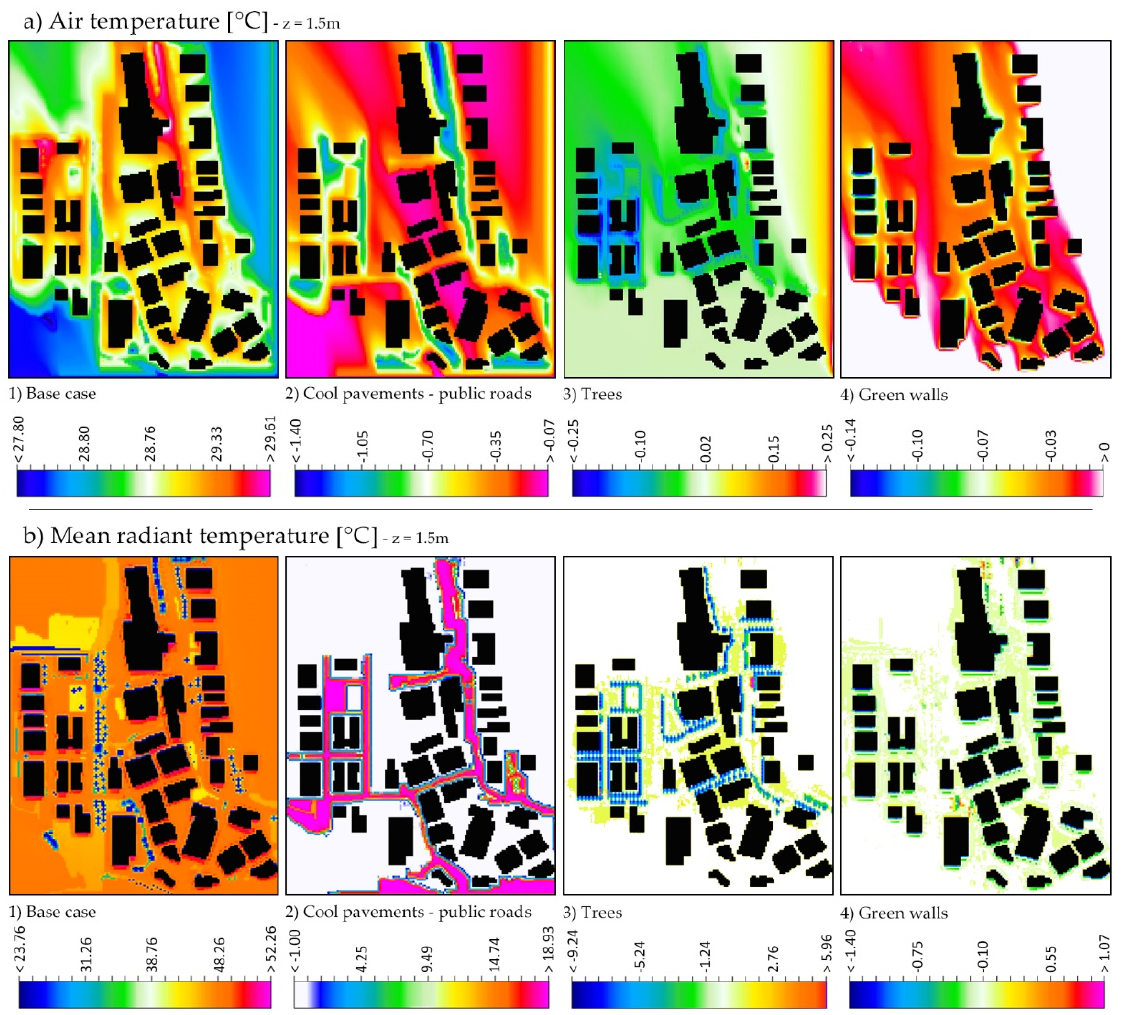
Figure 6. Variation in the air temperature between the base case ( a.1 ) and the configurations adopting the cool pavements, tree planting and green wall installations ( a.2 , a.3 , a.4 , respectively). In section b, a comparison between the values of the mean radiant temperature in the base case ( b.1 ) and the ones achieved by implementing the different interventions proposed.